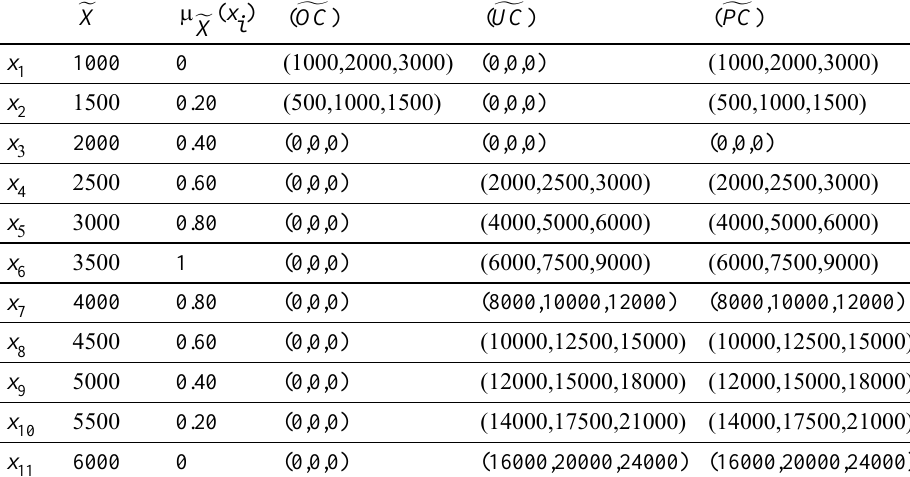
Table 3. Unit penalty cost values for January, Q = 2000